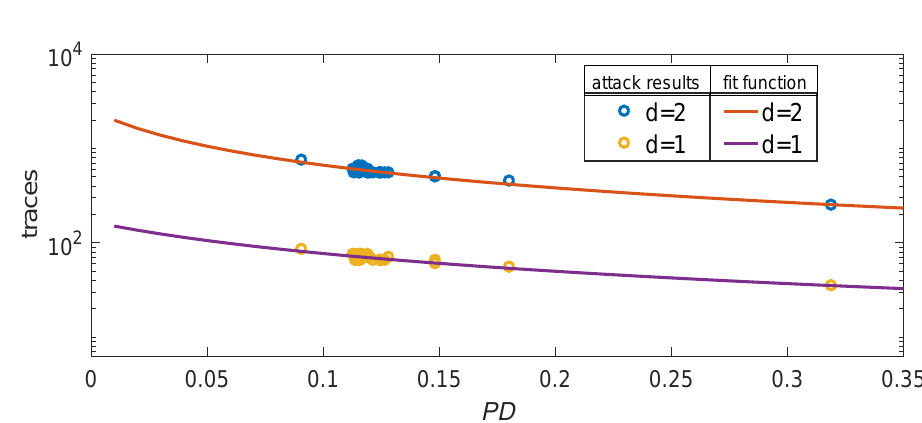
Figure 4: Number of traces for the GE to be below 10 (in y-axis) versus the different PD (in x-axis) for n = 8 and σ = 0 .